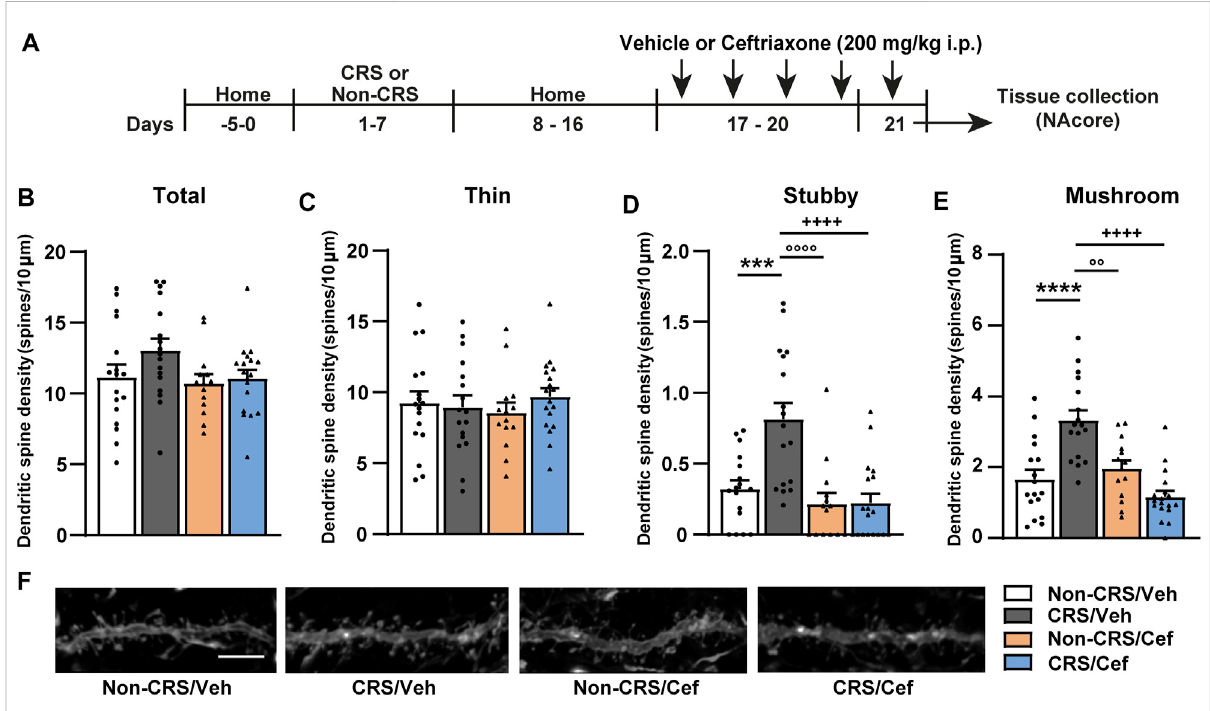
FIGURE 6 CeftriaxonepreventedtheCRS-inducedincreaseinthedensityofstubbyandmushroom-shapeddendriticspinesintheNAcore. (A) Schematic timeline of theexperimental protocol. (B – E) In fl uence of ceftriaxone treatment on total, thin, stubby and mushroom-shaped dendritic spine density expressed per 10 µm of NAcore MSN dendrite segment. Three to six segments were analyzed per animal. Total data analyzed: Non-CRS/Veh (17 segments; 800 µm dendritic length, four rats), CRS/Veh (17 segments; 734 µm dendritic length, four rats), Non-CRS/Cef (14 segments; 600 µm dendritic length, four rats) and CRS/Cef (18 segments; 753 µm dendritic length, four rats). Total and thin spine density: Two-way nested design ANOVA revealed no effect of stress or treatment either for total (Non-CRS vs. CRS; F (1,13) = 0.62, n.s. – Veh vs. Cef; F (1,13) = 2.03, n.s.) or thin spine densities (Non-CRS vs. CRS; F (1,13) = 0.001, n.s. – Veh vs. Cef; F (1,13) = 0.002, n.s.). Although two-way nested design ANOVA revealed interaction for total (Non-CRS vs. CRS x Veh vs. Cef; F (1,13) = 595.85, p < 0.0001) and thin spine densities (Non-CRS vs. CRS x Veh vs. Cef; F (1,13) = 271.57, p < 0.0001),one-wayANOVAtotestsigni fi cantvariationsinmeansamonggroupsshowednostatisticaldifferencesamongthemeitherfortotal(F (3,62) = 1.93, n.s.) or thin spine densities (F (3,62) = 0.38, n.s.). Stubby spine density: Two-way nested design ANOVA revealed signi fi cant interaction (Non-CRS vs.CRSxVehvs.Cef;F (1,13) =53.98, p < 0.0001),effectofstress(Non-CRSvs.CRS;F (1,13) =5.78, p < 0.05)andtreatment(Vehvs.Cef;F (1,13) =9.50, p < 0.01). One-way ANOVA showed signi fi cant variations in means among groups for stubby spine density (F (3,62) = 12.06, p < 0.0001), Bonferroni post- hoc test revealed signi fi cant differences comparing Non-CRS/Veh with CRS/Veh (*** p < 0.001) and CRS/Veh with CRS/Cef (++++ p < 0.0001). Ceftriaxone treatment did not evidence a per se effect on stubby spine density as shown comparing Non-CRS/Cef with Non-CRS/Veh (n.s.) and Non-CRS/Cef with CRS/Veh ( °°°° p < 0.0001). Mushroom-shaped spine density: Two-way nested design ANOVA revealed interaction (Non-CRS vs.